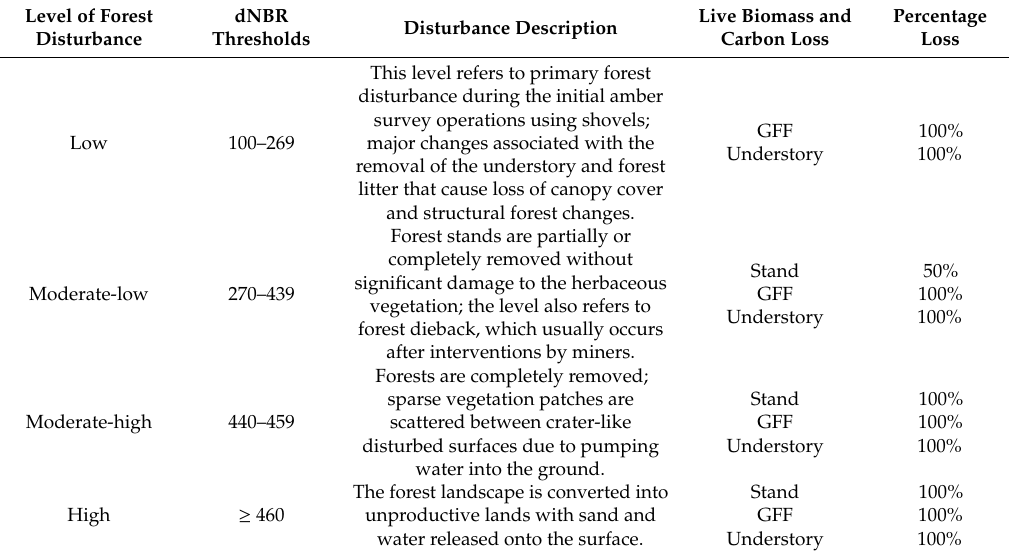
Table 3. Descriptions of forest disturbance levels due to amber mining extracted through interpretation of the VR360 panoramic